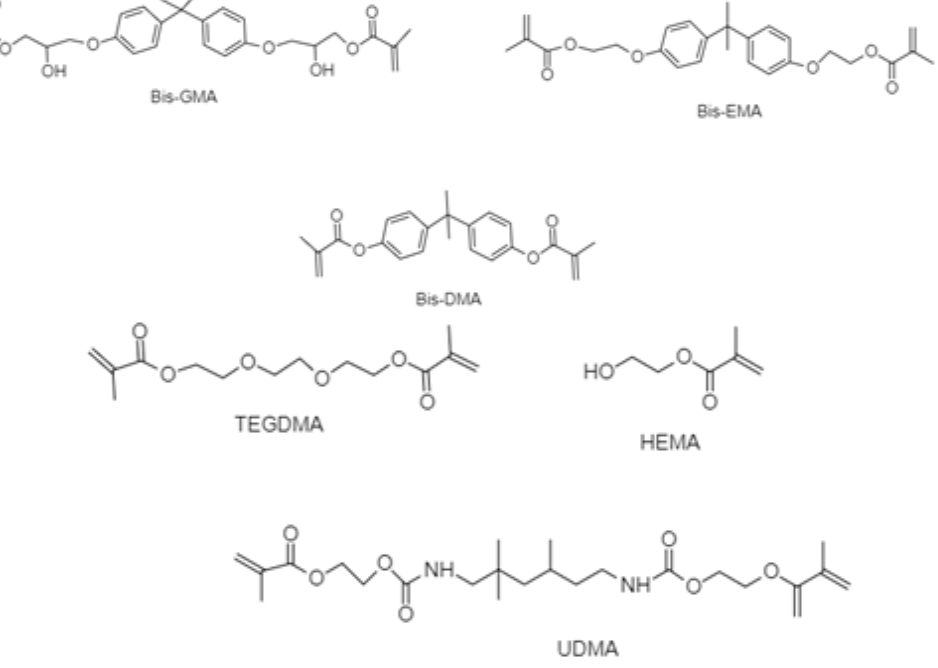
Figure 1. Most commonly used monomers in modern dental materials .